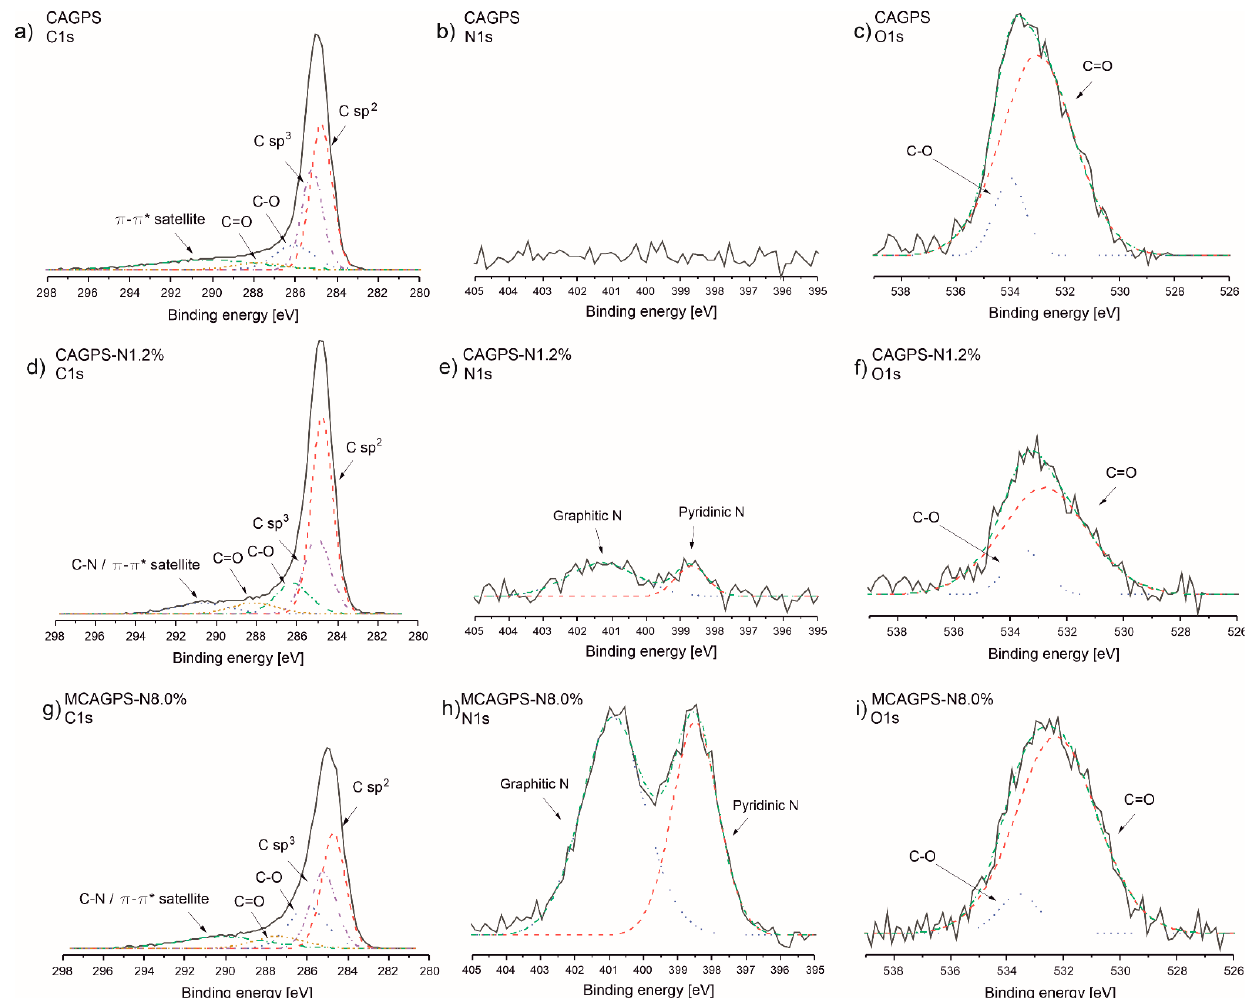
Figure 7. The X-ray photoelectron spectra of investigated ( a – c ) CAGPS, ( d – f ) CAGPS-N1.2%, and ( g – i ) MCAGPS-N8.0% materials (MCAGPS—carbon aerogel made from potato starch modified with melamine; CAGPS-N—carbon aerogel made from potato starch modified by N 2 pyrolysis; CAGPS—pristine carbon aerogel).